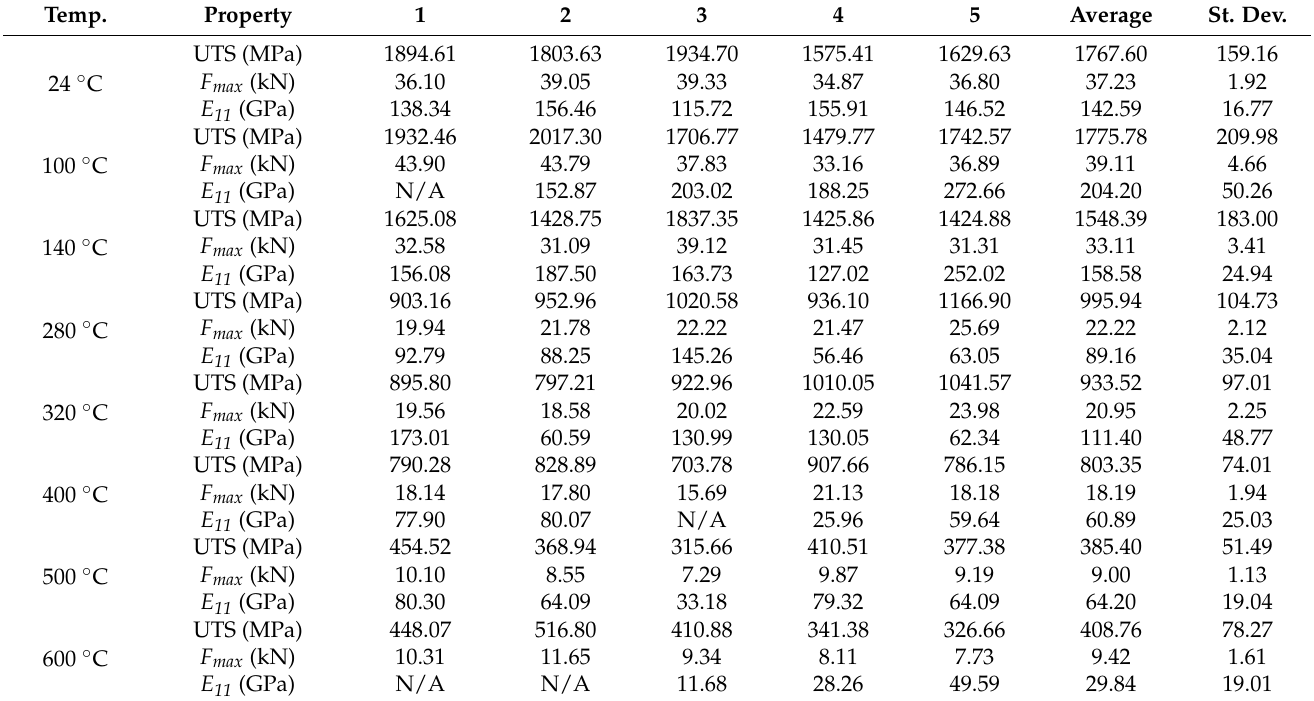
The arrows in Figure A2g,h indicate that the tests continued beyond the 6 mm exten- sion and the test was halted either because the straps could not carry any substantial load due to gradual unwinding of the plies or to avoid equipment damage. Table A2. Supplementary results used in SS analysis.